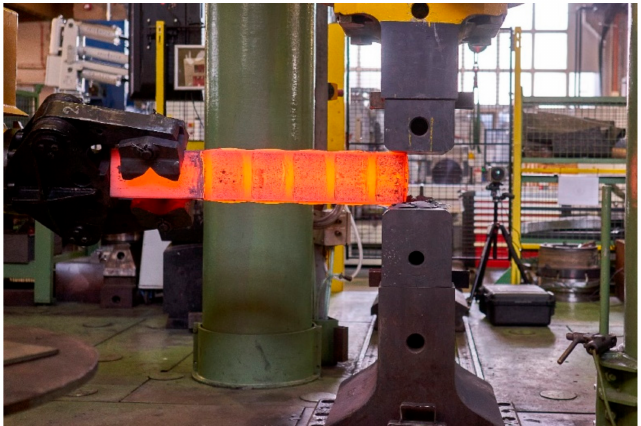
Figure 10. Photo from the forging experiment at the beginning of the first stroke of pass two.